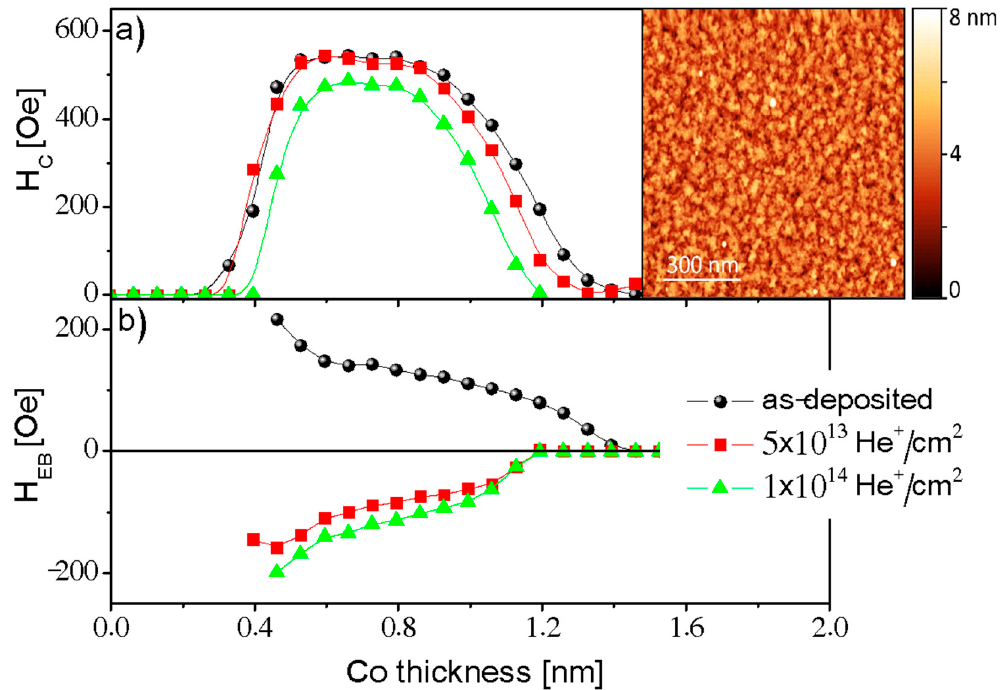
Figure 3. ( a ) Coercivity ( H C ) and ( b ) exchange bias field ( H EB ) for the Ti/Au/Co-wedge/NiO/Au sample with perpendicular magnetic anisotropy, before and after 10 keV He + ion bombardment in an external magnetic field ( H IB ) applied in the direction opposite to H dep . The solid lines are guided to the eye. The inset shows the topography of the Ti/Au/Co/NiO/Au sample registered using atomic force microscopy.